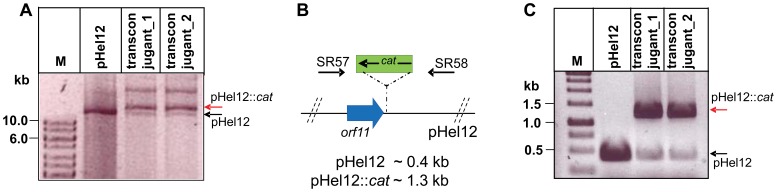
Confirmation of pHel plasmid transfer into transconjugants.(A) Isolation of plasmid DNA from transconjugants after co-cultivation of H. pylori P12 donor and recipient strains. Isolation of plasmid DNA after co-cultivation of H. pylori P12 pHel12::cat (donor) with H. pylori P12[moeB::aphA-3]. Presence of the donor plasmid pHel12::cat in the recipient strain (red arrow, lane 3,4) and of the recipient plasmid pHel12 (black arrow, lanes 3 and 4) is shown. Lane 1: 1 kb ladder, lane 2: pHel12, lane 3: transconjugant 1, lane 4: transconjugant 2. (B) Scheme explaining the PCR for the specific detection of donor- and recipient plasmid in transconjugants using oligos SR57 and SR58. (C) PCR fragments obtained with primers SR57/SR58 for the donor plasmid (red arrow, 1.3 kb) and for the original pHel12 plasmid of the recipient strain (black arrow, 0.4 kb). Lane 1, 1 kb ladder, lane 2, pHel12 used as template, lane 3 and 4, plasmid DNA from transconjugants 1 and 2 used as template.